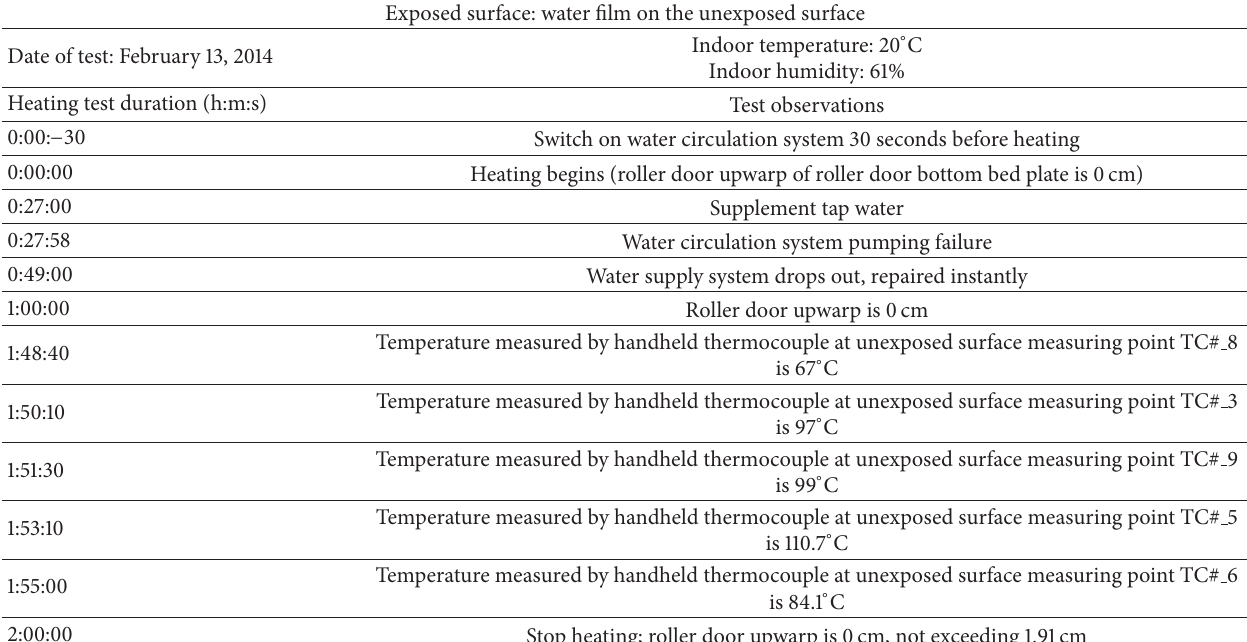
Table 1: Heating test record of high-speed roller door with water film on unexposed surface. Exposed surface: water film on the unexposed